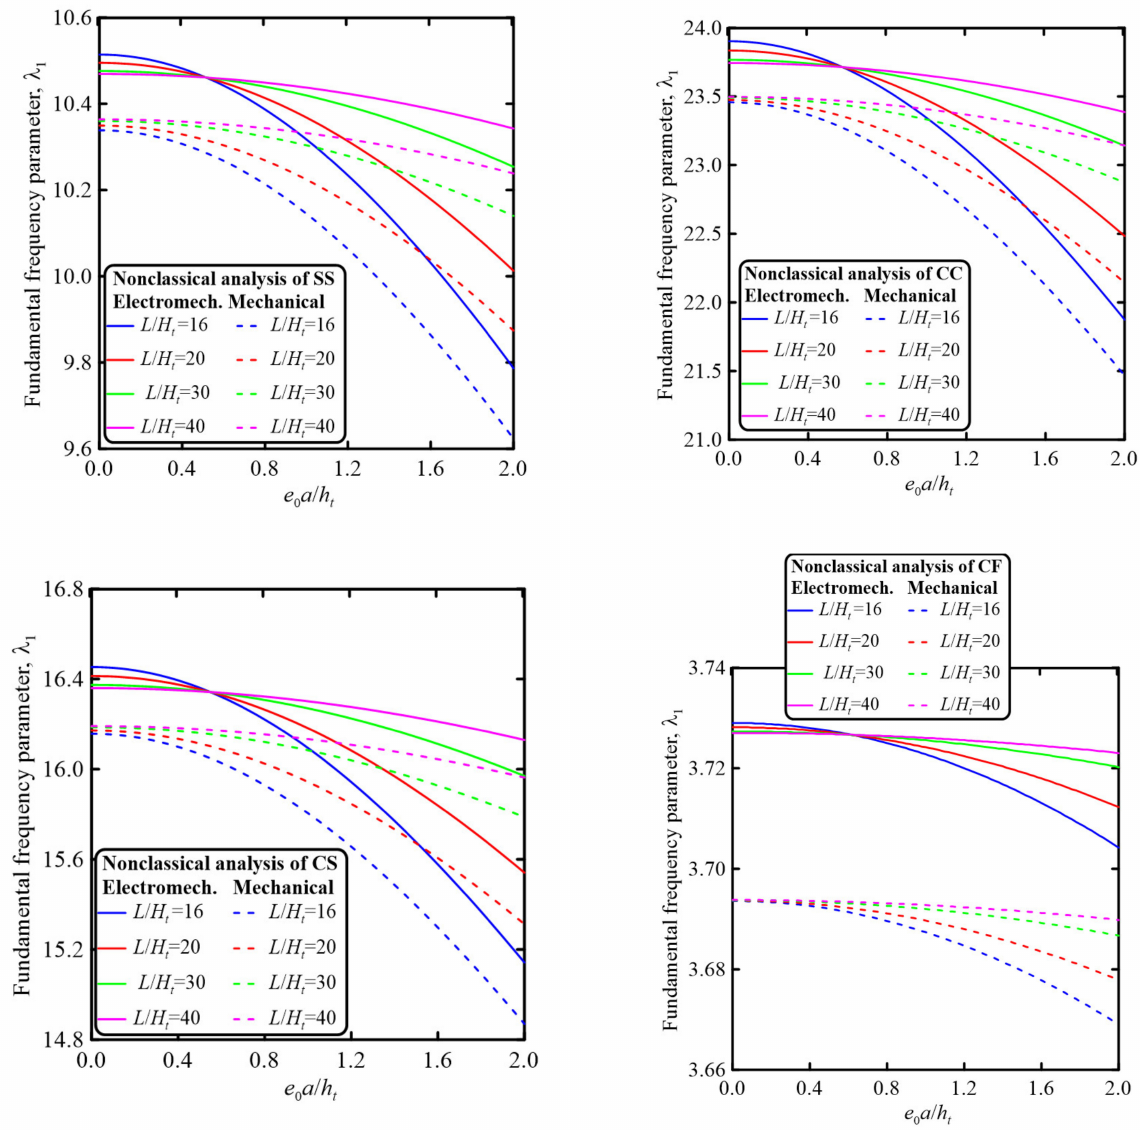
Figure 5. Variation of the fundamental frequency parameter λ 1 with the normalized nonlocal pa- rameter e 0 a / h t for nonclassical electromechanical and mechanical analyses of piezoelectric sandwich nanobeams for different beam boundary conditions at α = 0.5 and beam aspect ratio L / h t = 20 (N =